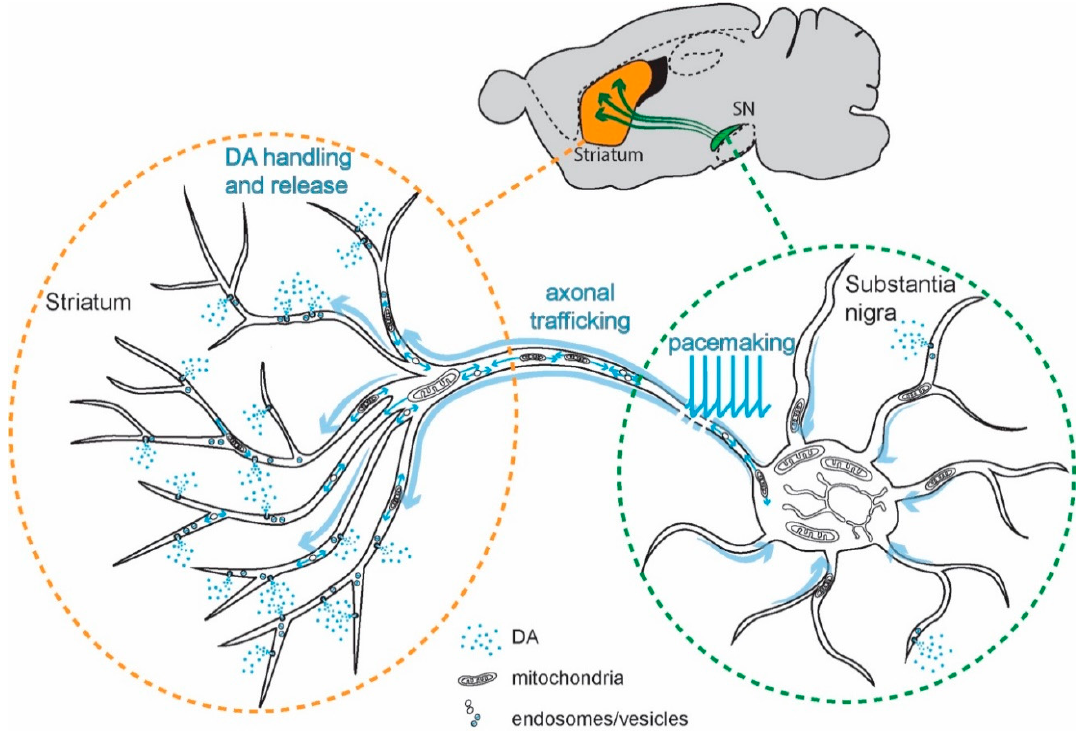
Figure 1. Schematic representation of a substantia nigra (SN) dopaminergic (DAergic) neuron, its axonal projections, and the factors contributing to its high bioenergetic demands. Inset: the positions of substantia nigra (SN, green) and the striatum (orange) and nigral projections to the striatum. Main: sources of high energy demand in SN DAergic neurons. In neurons, three main processes are responsible for the bioenergetic burden: the maintenance of the axonal tree through anterograde/retrograde transport, the propagation of action potentials (APs) followed by the re- establishment of ionic gradients, and the synaptic vesicles cycling. SN DAergic neurons have particularly high energetic demands because of the huge size of their axon, the autonomous pacemaking activity coupled to broad APs, and the high number of synapses or dopamine (DA) release sites. Note that DA release occurs not only from the axonal domain but also in the somatodendritic region.